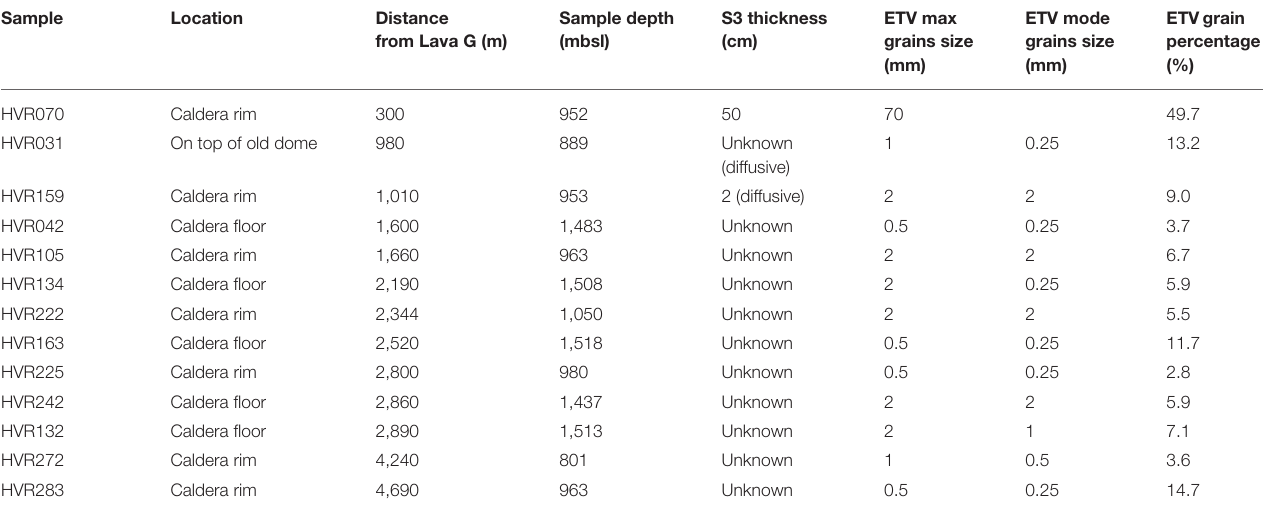
TABLE 1 | Characteristics of samples containing Elongate tube-vesicle particles (S3) at Havre.